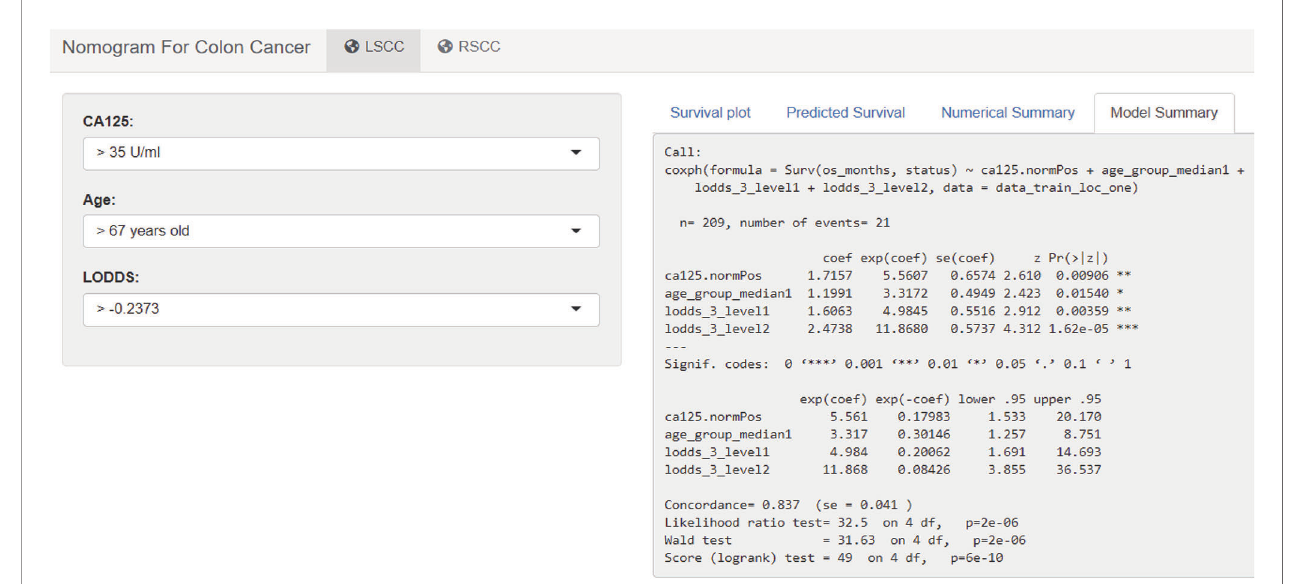
FIGURE 5 | Development of webserver for easy access of nomogram